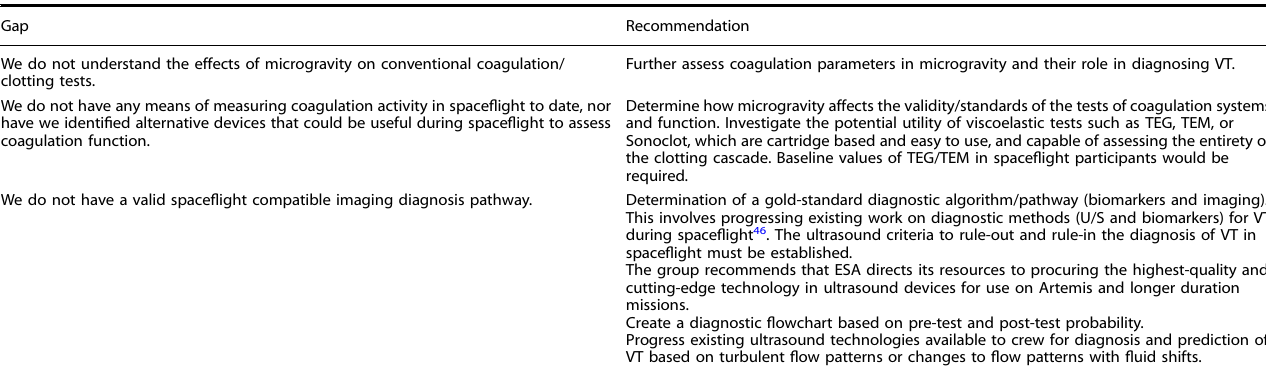
Table 4. Diagnosis - Gap Analysis and